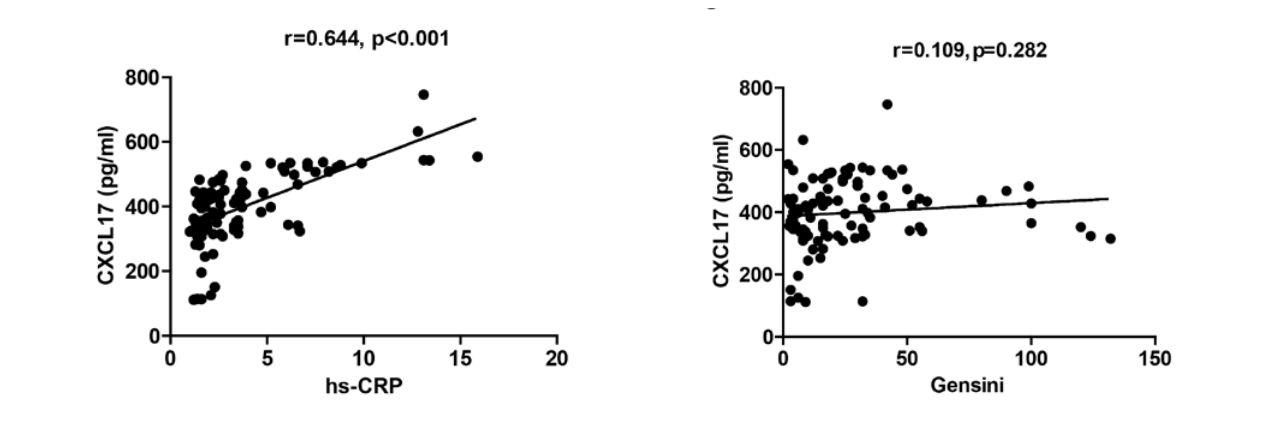
Figure 2: The correlation between CXCL17, Gensini score. The CXCL17 level in serum of patients with UA and the related Gensini score. UA: unstable angina.